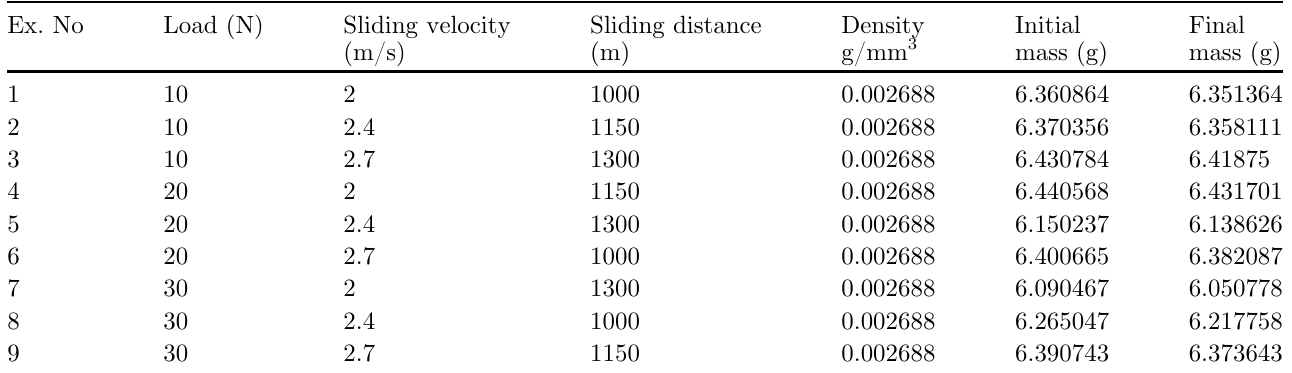
Table 3. Experimental plan and